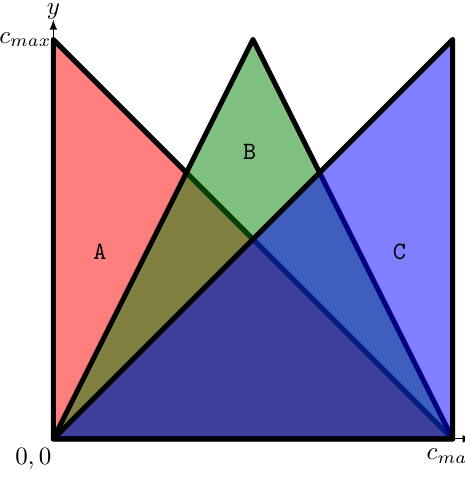
Figure 3. Triangles with maximum possible